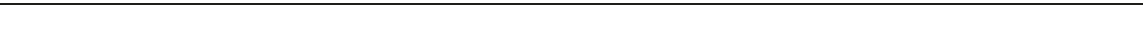
Fig. 5 CENP-AS7 phosphorylation is involved in sister chromatid cohesion and Sgo1 maintenance at centromeres in response to tension. a Chromosome spreads from CENP-A-HA-WT, CENP-A-HA-S7A, and CENP-A-HA-S7D cells depleted of endogenous CENP-A were immunostained for Sgo1 and HA. Magni fi cations (× 9) are shown. In the CENP-A-HA-S7A cell line, the presence and absence of Sgo1 immunostaining at the centromere of joined (empty arrow) or separated sister chromatids (full arrow and asterisk), respectively, are shown. Scale bar = 5 µ m. b CENP-A-HA-WT and CENP-A-HA-S7A cell lines were treated or not with nocodazole for 3 hours. The means± SD of PSCS percentages are shown on the left ( n = 2 experiments; > 150 cells per experiment were counted; **** P < 0.0001; *** P < 0.001; NS, not signi fi cant; two-way ANOVA). Quanti fi cations of Sgo1 in cell lines presenting joined or separated sister chromatids (SC) are shown on the right. The graph shows the means± SEM from a representative experiment ( n = at least 22 cells; **** P < 0.0001; *** P < 0.001; ** P < 0.01; NS, not signi fi cant; non-parametric Kruskal – Wallis test). c CENP-A-HA-WT, CENP-A-HA-S7A and CENP-A-HA-S7D cell lines depleted from endogenous CENP-A were treated with 20 µ M MG132 for 6 h and PSCS were scored. Means ± SD for the proportion of cells displaying PSCS are shown ( n = 4 experiments; > 150 cells per experiment were counted; **** P < 0.0001; *** P < 0.001; ** P < 0.01; two-way ANOVA). d Means ± SEM from a representative experiment quantifying Sgo1 fl uorescence intensity on joined or separated SC after the depletion of endogenous CENP- A in CENP-A-HA-WT, CENP-A-HA-S7A, and CENP-A-HA-S7D cell lines further treated with 20 µ M MG132 for 6 h ( n = 23 – 26 cells, except for S7D with separated SC where n = 14; **** P < 0.0001; *** P < 0.001; ** P < 0.01; * P < 0.1; NS, not signi fi cant; non-parametric Kruskal – Wallis test). e CENP-A-HA-WT and CENP-A-HA-S7A cell lines depleted from endogenous CENP-A and synchronized as indicated were scored for PSCS after 3 or 6 h following nocodazole or MG132 treatment. The means ± SD of PSCS percentages are shown on the left ( n = 2 experiments; > 200 cells per experiment). Right panel: mitotic indexes ( n = 2 experiments, > 400 cells per